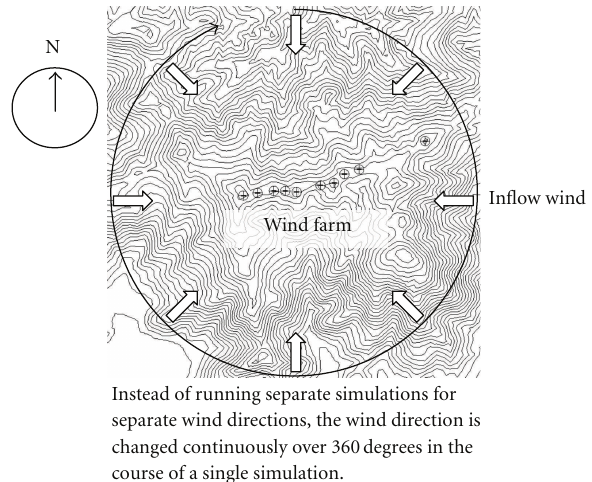
Figure 4: Continuous change of wind